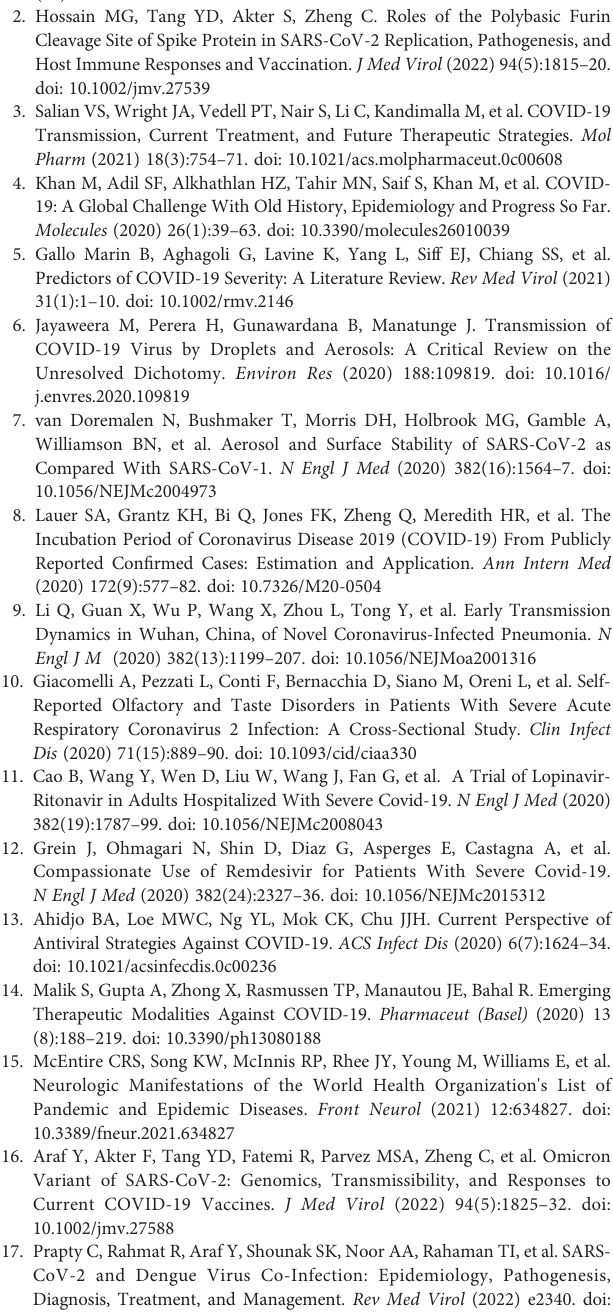
Supplementary Table 2 | Related targets of COVID-19. Supplementary Table 3 | Related targets of EHF. Supplementary Table 4 | Common gene of COVID-19, EHF, puerarin.